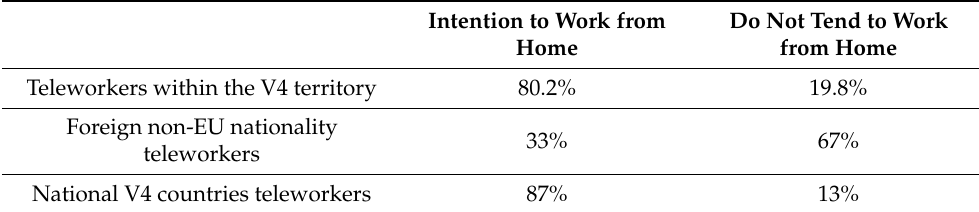
Table 4. V4 countries teleworkers’ intention to work from home in future: foreign non-EU citizens vs. nationals.